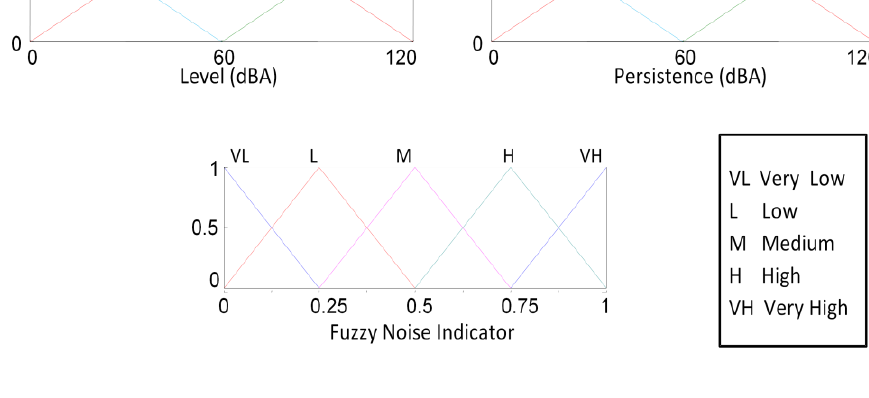
Table 6. Set of rules